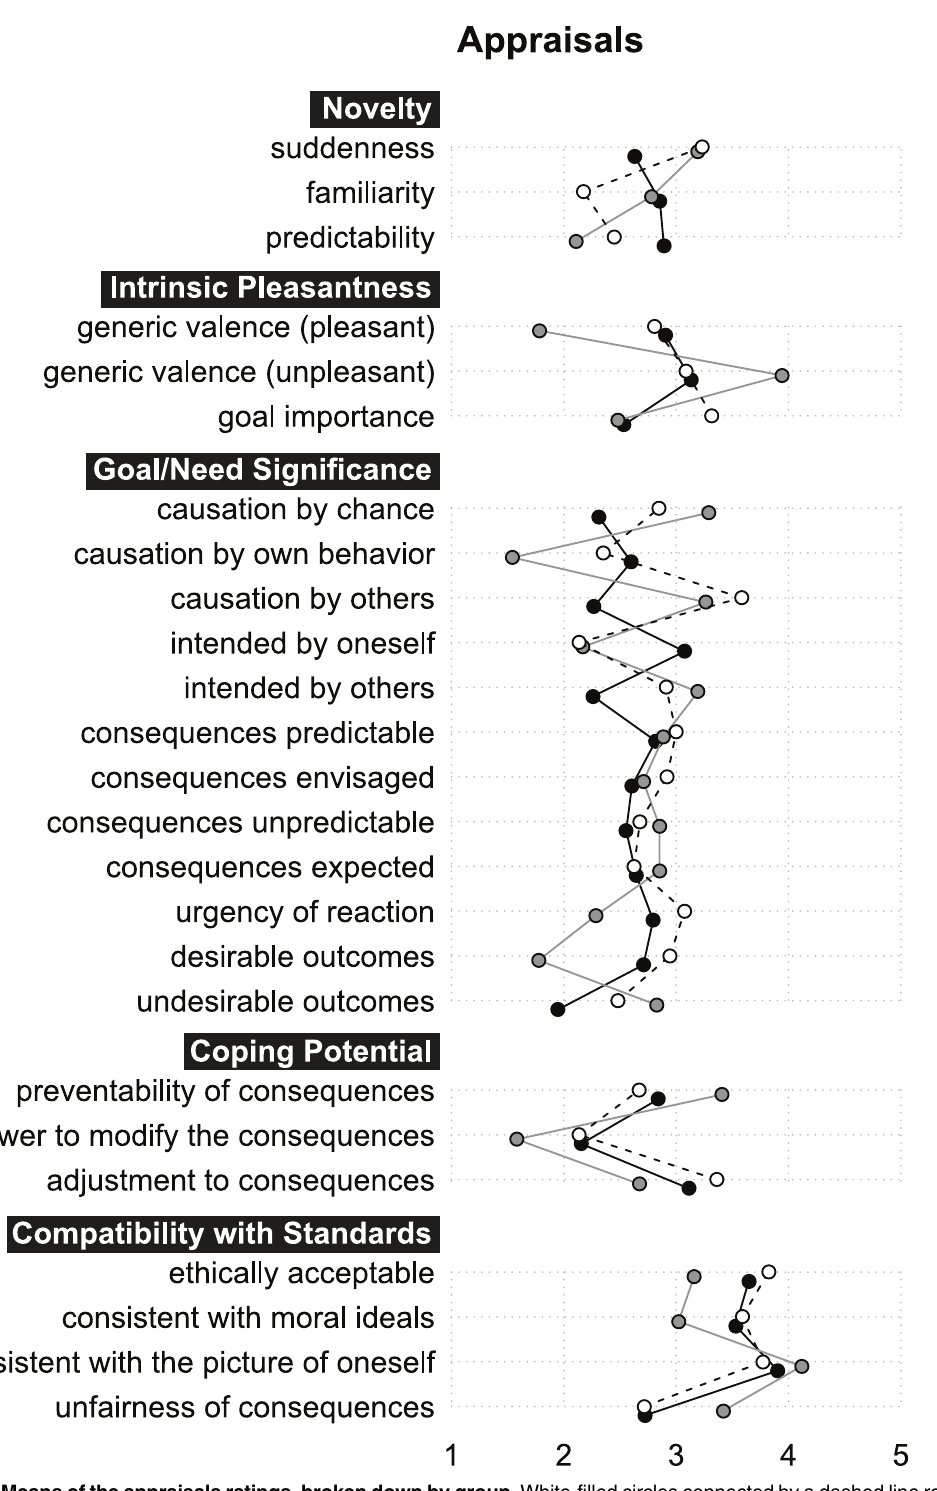
Fig 2. Means of the appraisals ratings, broken down by group. White-filled circles connected by a dashed line represent the own-life events group. Grey- filled circles connected by a grey line represent the media-represented real events group. Black-filled circles connected by a black line represent the fictional events